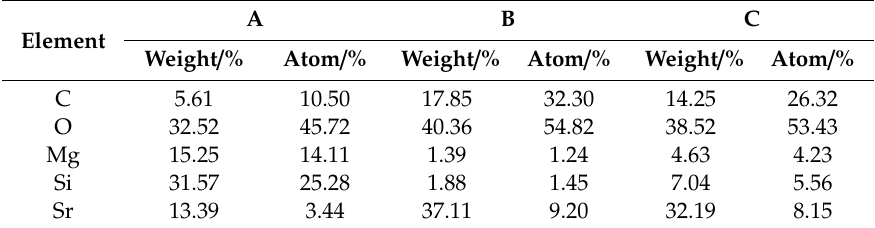
Table 3. Energy dispersive spectrometry (EDS) analysis of the MgO–SiO 2 –H 2 O solidified body with 3.2 wt.% Sr 2 + , cured for 28